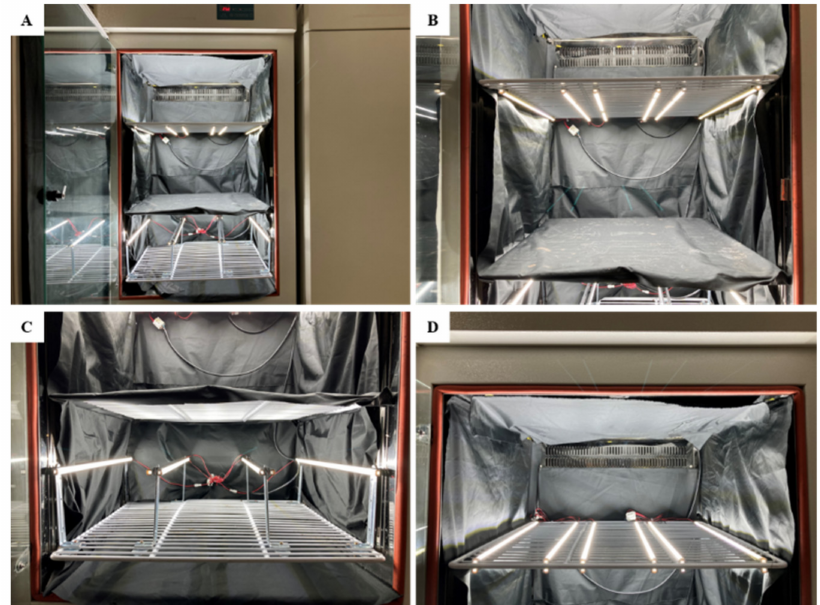
Figure 9. The plant growth chamber used in the study ( A ) and the light-emitting diode (LED) installed from the top ( B ), side ( C ), and bottom ( D ) relative to the